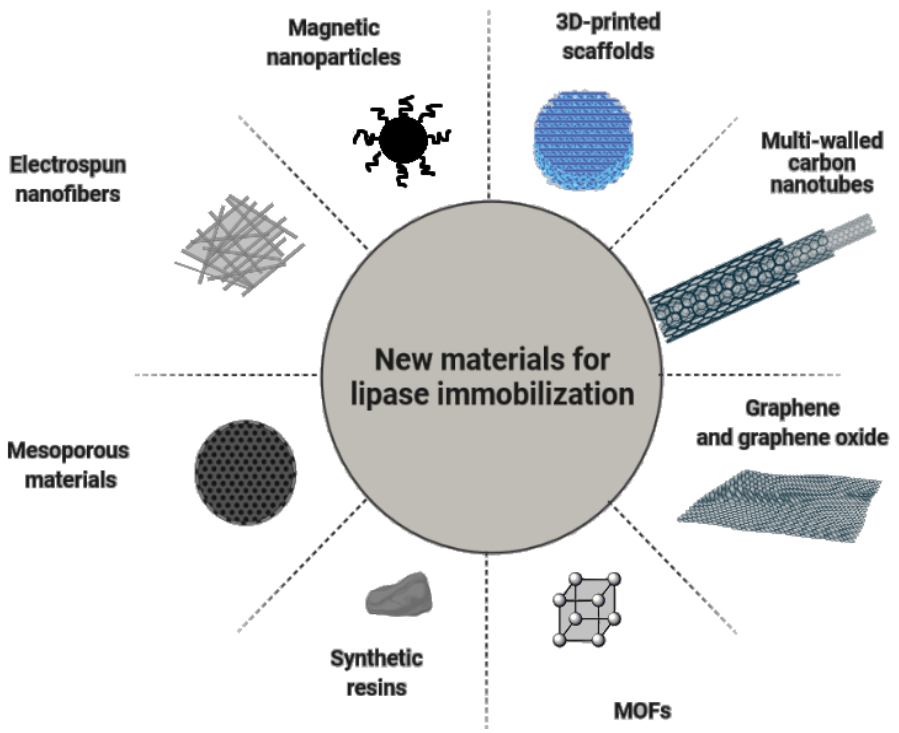
Figure 10. Novel materials used for lipase immobilization. Table 1. Novel research in lipase immobilization.